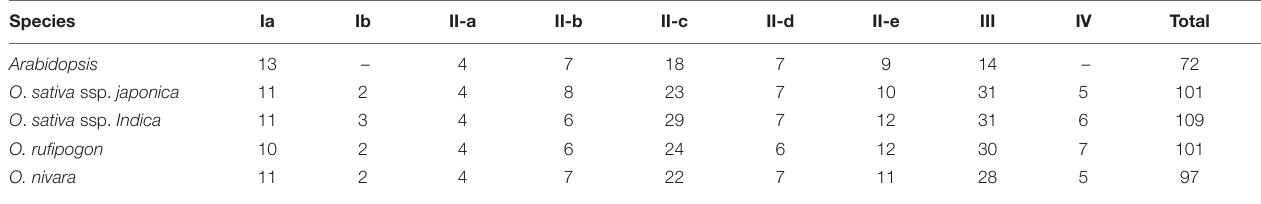
TABLE 1 | Number of WRKY genes in Arabidopsis , cultivated rice, and wild